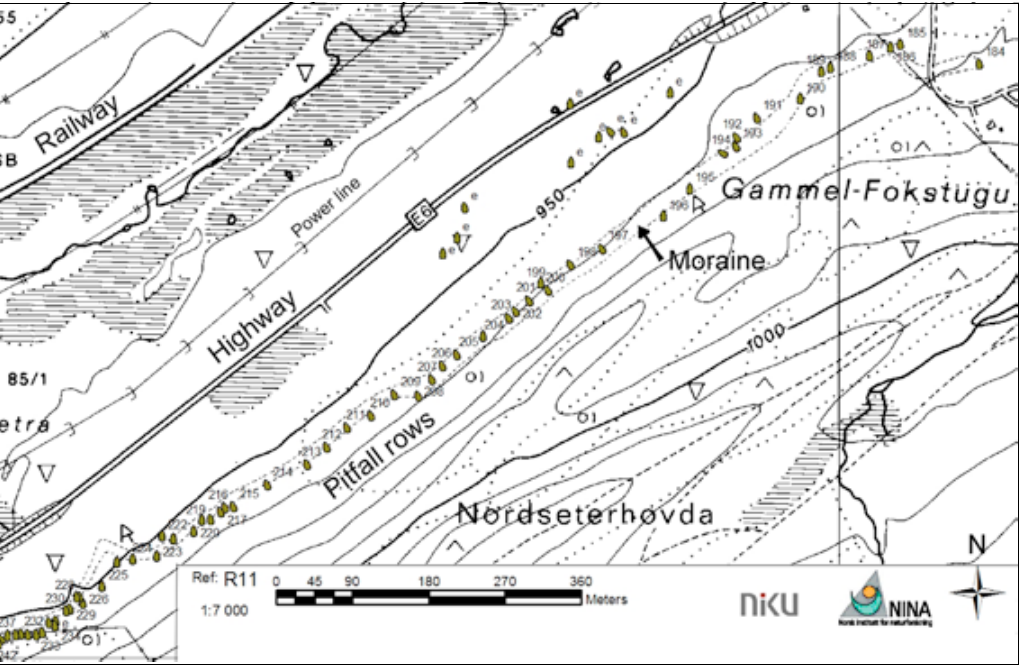
Fig. 5. Details from the south-western part of the trapping system at Dovrefjell. Most of the pitfalls are placed in longitudinal moraines. The individual pitfall traps are aligned so that their long axis is about 0 degrees to the the line of the valley. The line of traps runs parallel to the line of the valley (Jordhøy, 2005).